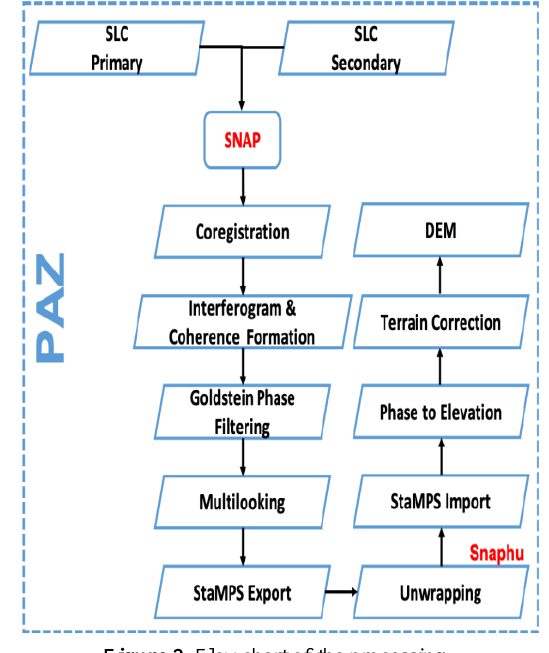
Figure 2. Flowchart of the processing.